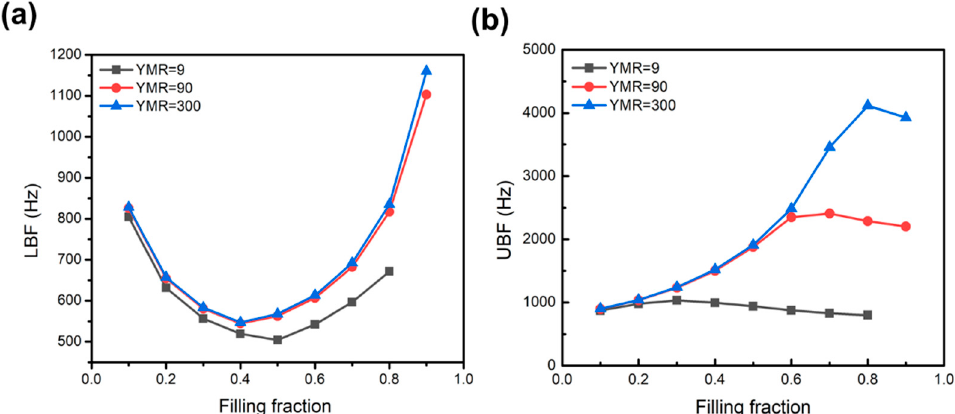
Figure A1. ( a ) Lower bound frequency (LBF) and ( b ) upper bound frequency (UBF) of the bandgap versus the filling fraction of a single-inclusion phononic crystals with different YMRs of 9, 90, and 300.